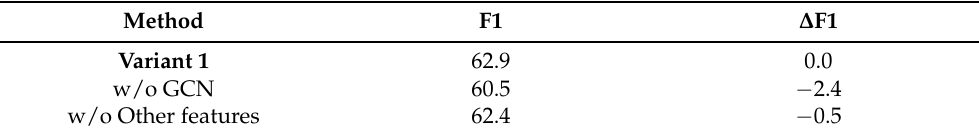
Table 3. Ablation study for Variant 1 .